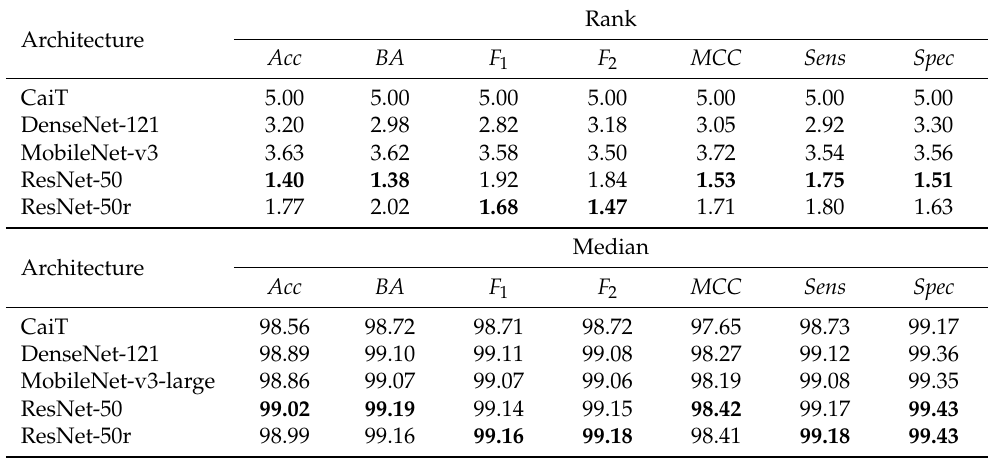
Table 8. Ranks and medians by architecture after 1000 bootstrapping cycles. Best results are high- lighted in bold.